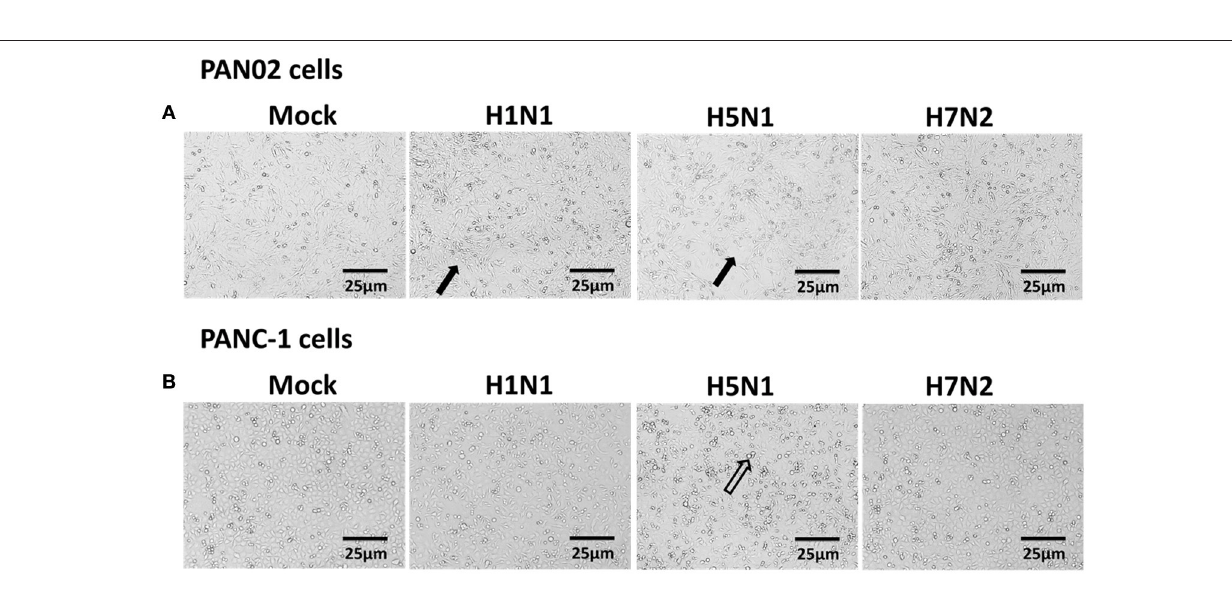
FIGURE 5 | Cytopathic effects were induced in H5N1 IAV-infected pancreatic cells. (A) PAN02 and (B) PANC-1 cells were mock-treated or infected with H1N1, H5N1, or H7N2 at an MOI of 1 for 12h. Morphologic analysis of the effect of IAV infection on cell death were taken. Cell morphology was visualized by light microscopy. Black arrows indicate numerous rounded cells. Hollow arrows indicate dead cells. Bar = 25 µ